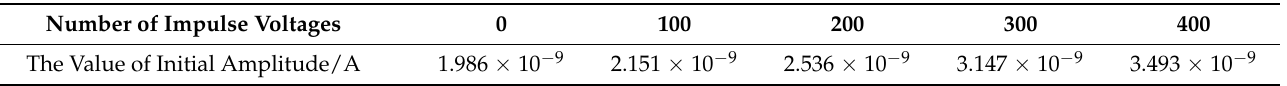
Figure 10. The polarization current curves of oil-film dielectrics under different degrees of aging. Table 2. The value of initial amplitude of oil-film dielectrics under different aging